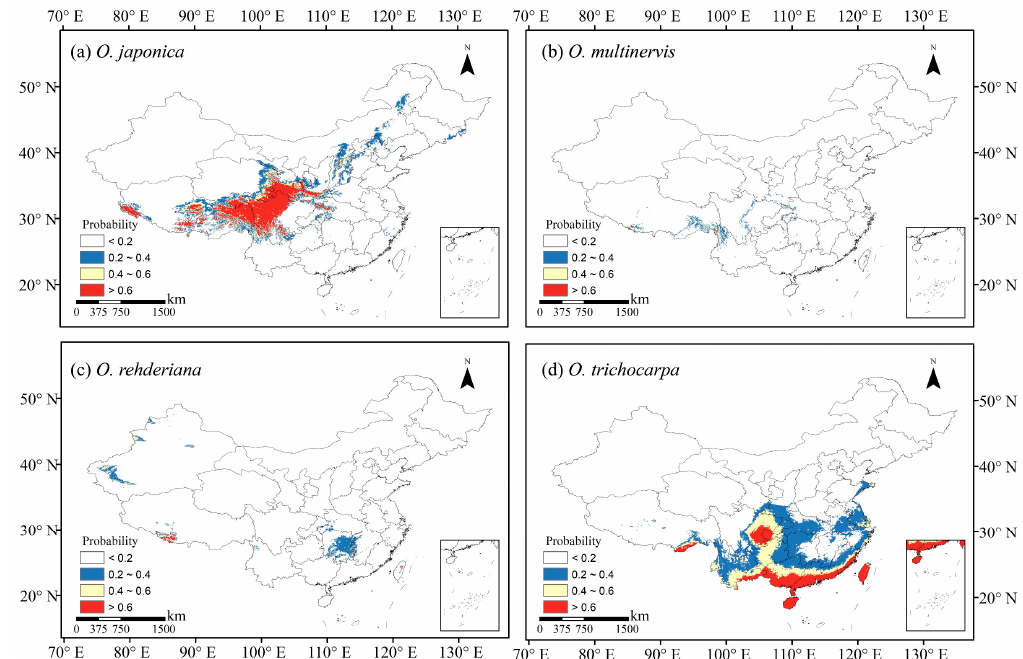
Figure A2. Potential habitats of four Ostrya species, i.e., O. japonica ( a ), O. multinervis ( b ), O. rehderiana ( c ), and O. trichocarpa ( d ), under the climate scenario BCC-CSM2-MR SSP5-8.5 in the period 2081–2100. The values for species occurrence probability ranged between 0 and 1, i.e., least potential (<0.2), moderate potential (0.2–0.4), good potential (0.4–0.6), and high potential (>0.6).